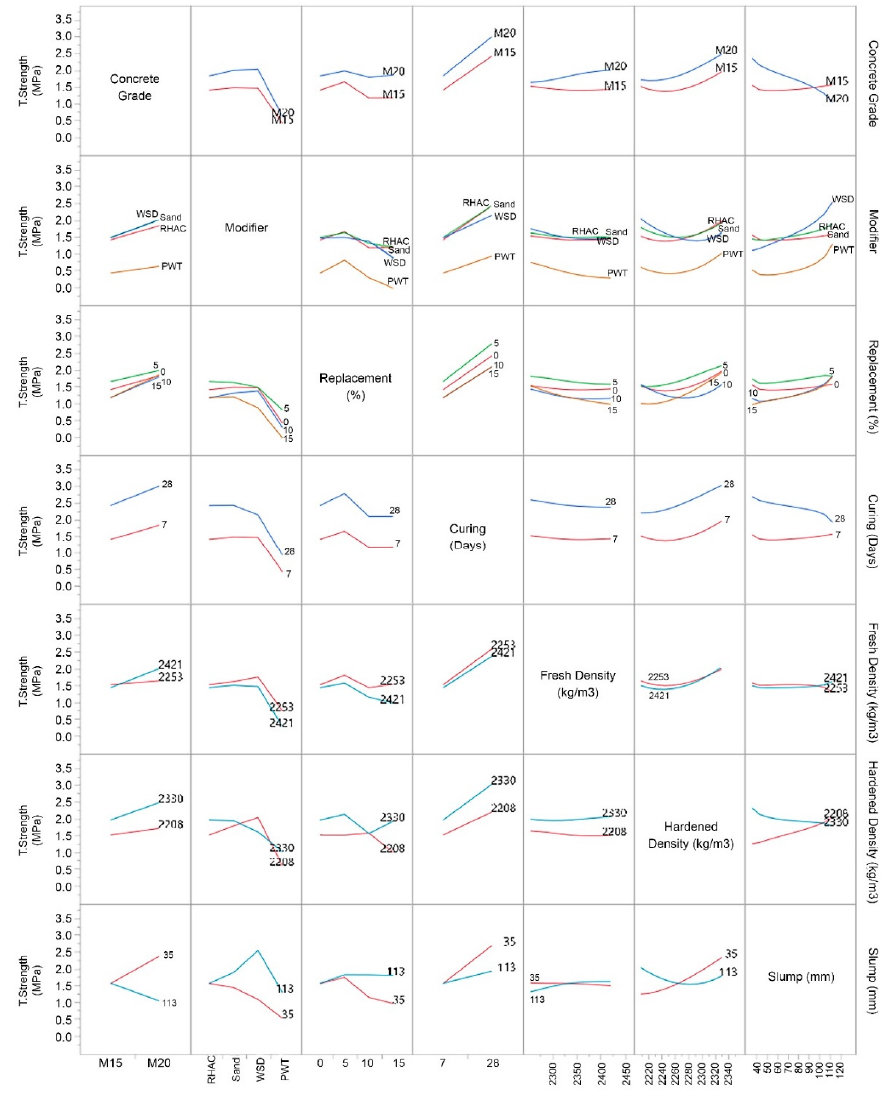
Figure 11. Tensile strength interaction profile.